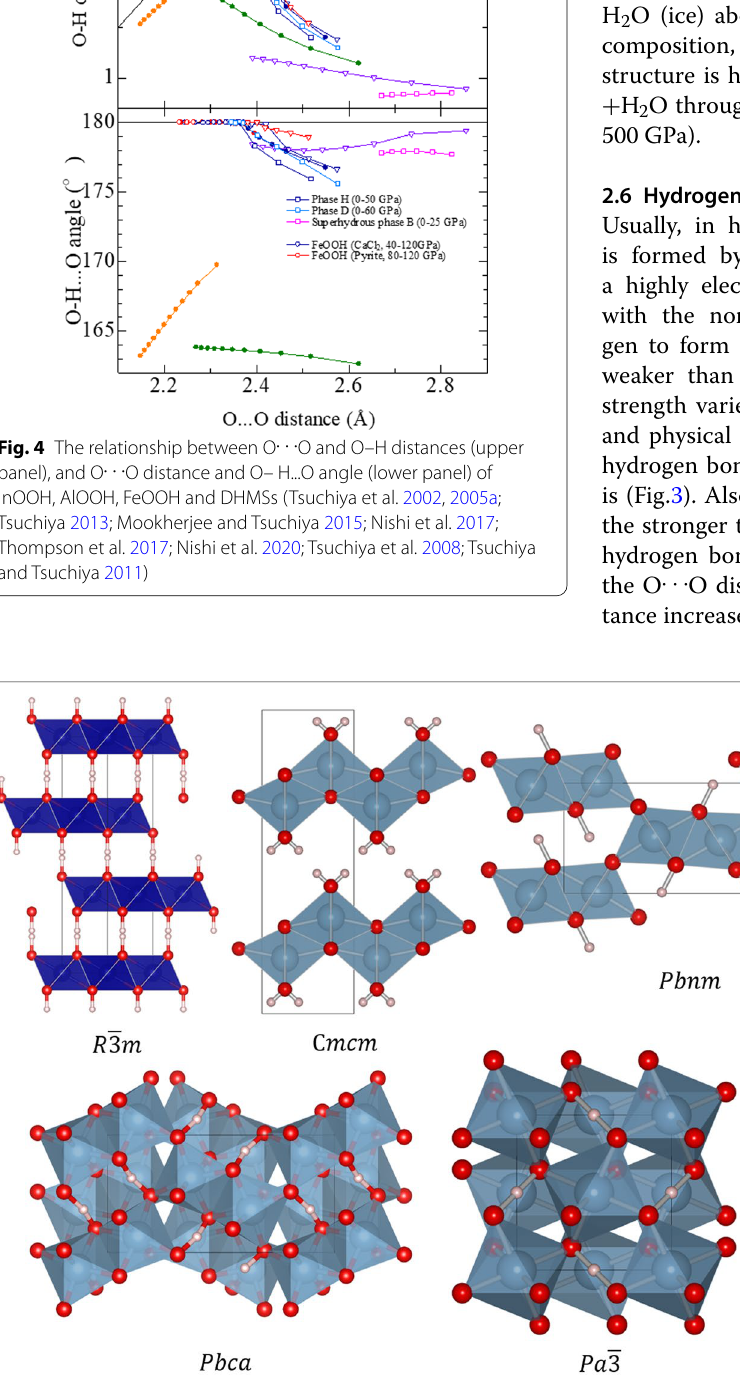
Fig. 5 Variety of the crystal structures of Oxyhydroxide